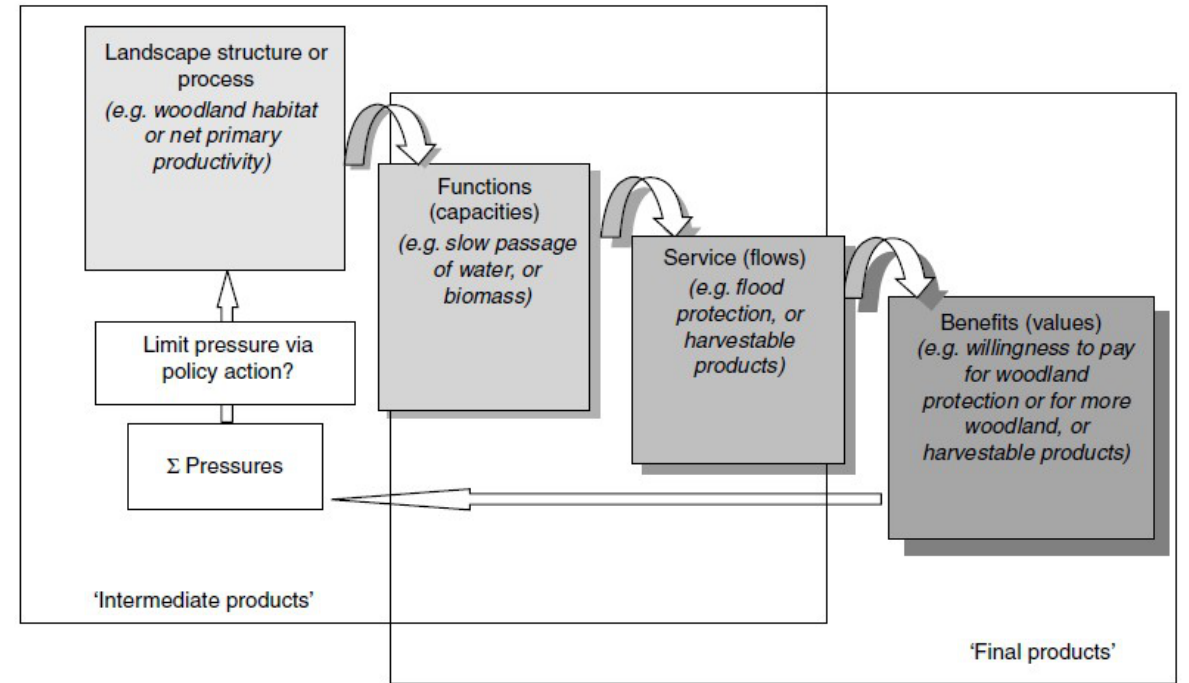
Figure 1: Ecosystem service cascade (Haines-Young & Potschin 2010) displaying benefits and values on the right hand side of the